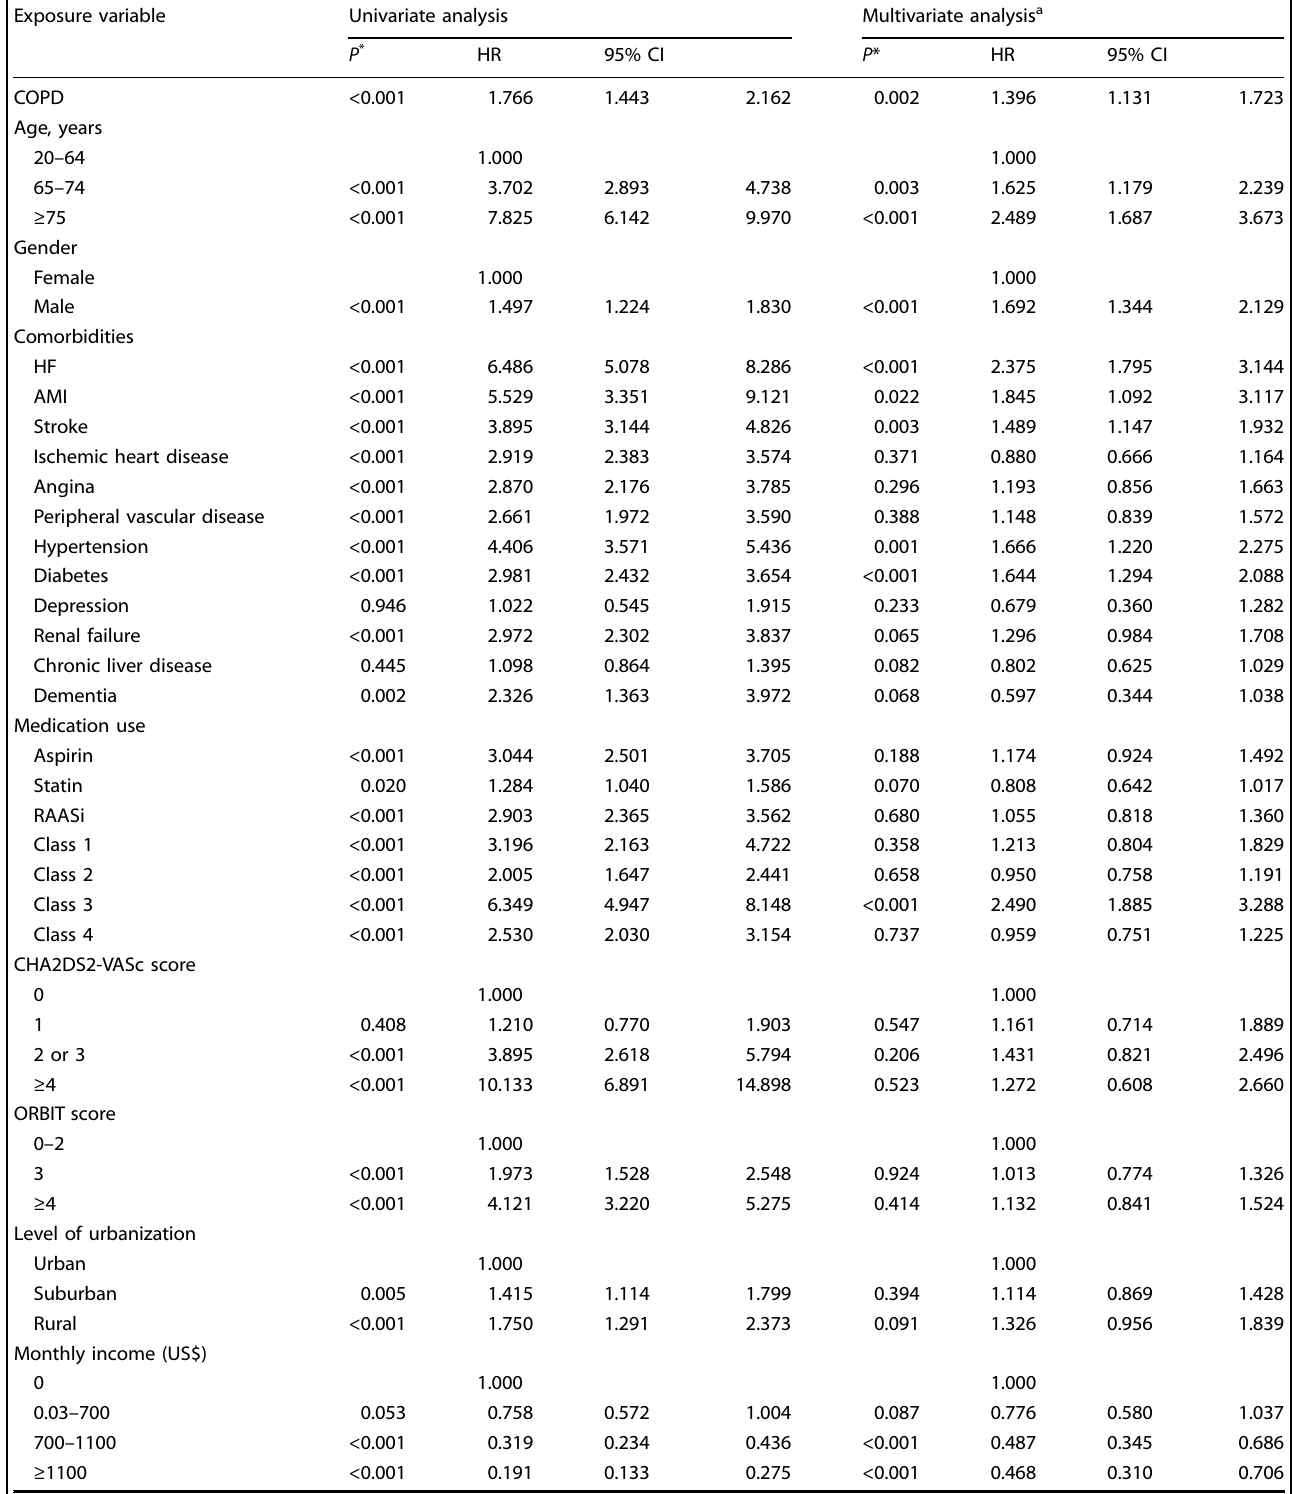
Table 5. Predictors of new-onset VA in COPD